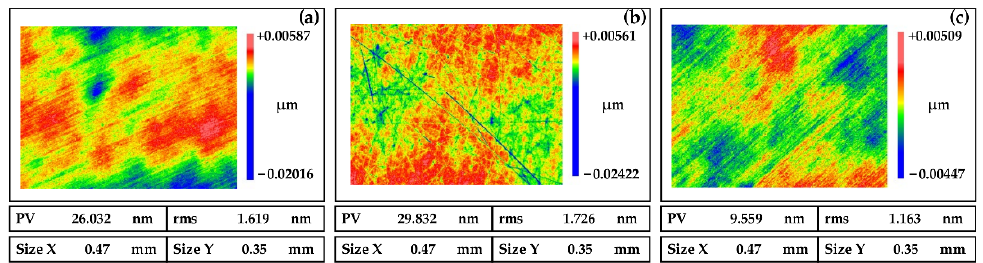
Figure 5. Polished surfaces of NiP coating induced by different abrasive ( a ) CeO 2 , ( b ) Al 2 O 3 , and ( c ) SiO 2 . ( c ) SiO 2